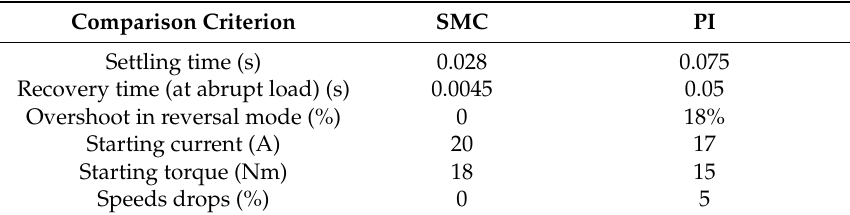
Table 3. Comparison between SMC and